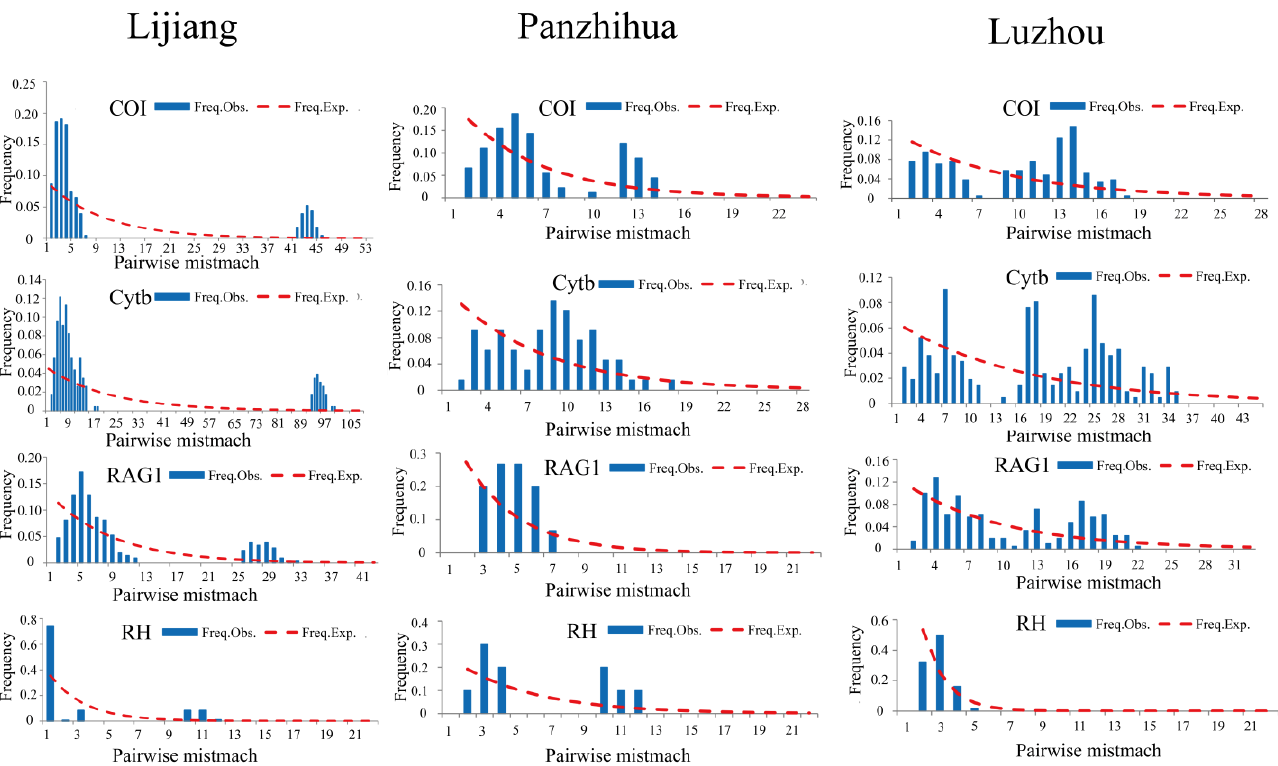
Figure 3. Expected (dashed red line) and observed (blue bar) mismatch distribution for Jinshaia sinensis based on all genes. X-axis = pairwise differences; Y-axis = frequency.